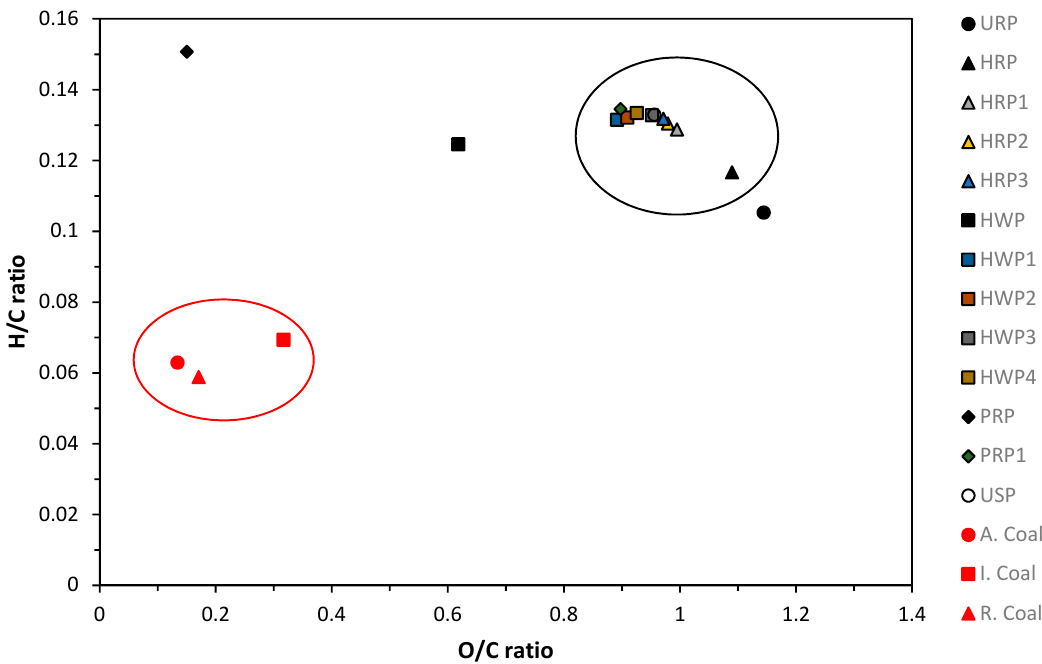
Figure 4. Comparison of elemental ratios between fuel pellets and coals.